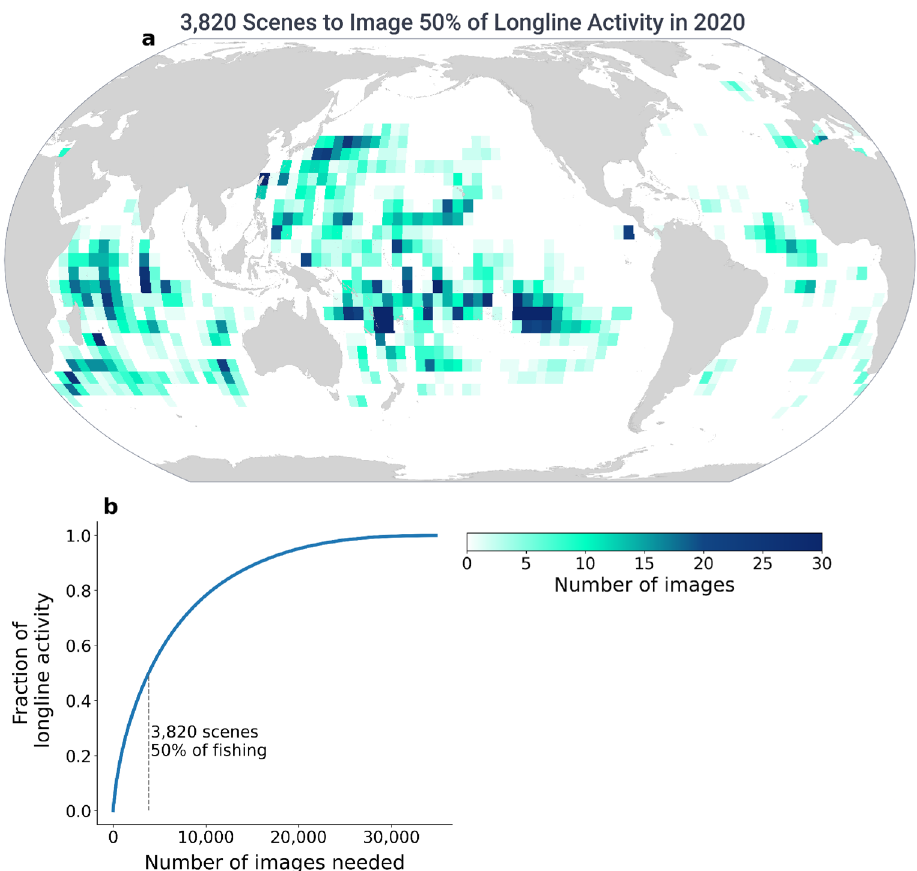
Figure 5. Half of the longline activity can be imaged by sampling only a small fraction of the ocean. Spatially ( a ) and temporarily (Fig. S7), longline activity is highly concentrated. Dividing the world into a four-by-four degree grid by 52 weeks for the calendar year 2020, half of the longline activity is in just 10% of the total cells where longline activity occurs ( b ). To image 50% of the longline activity, one would need 3820 scenes, distributed appropriately in space ( a ) and time (Fig. S7). Map generated using Python 3.9.6 and PySeas library (https:// github. com/ Globa lFish ingWa tch/